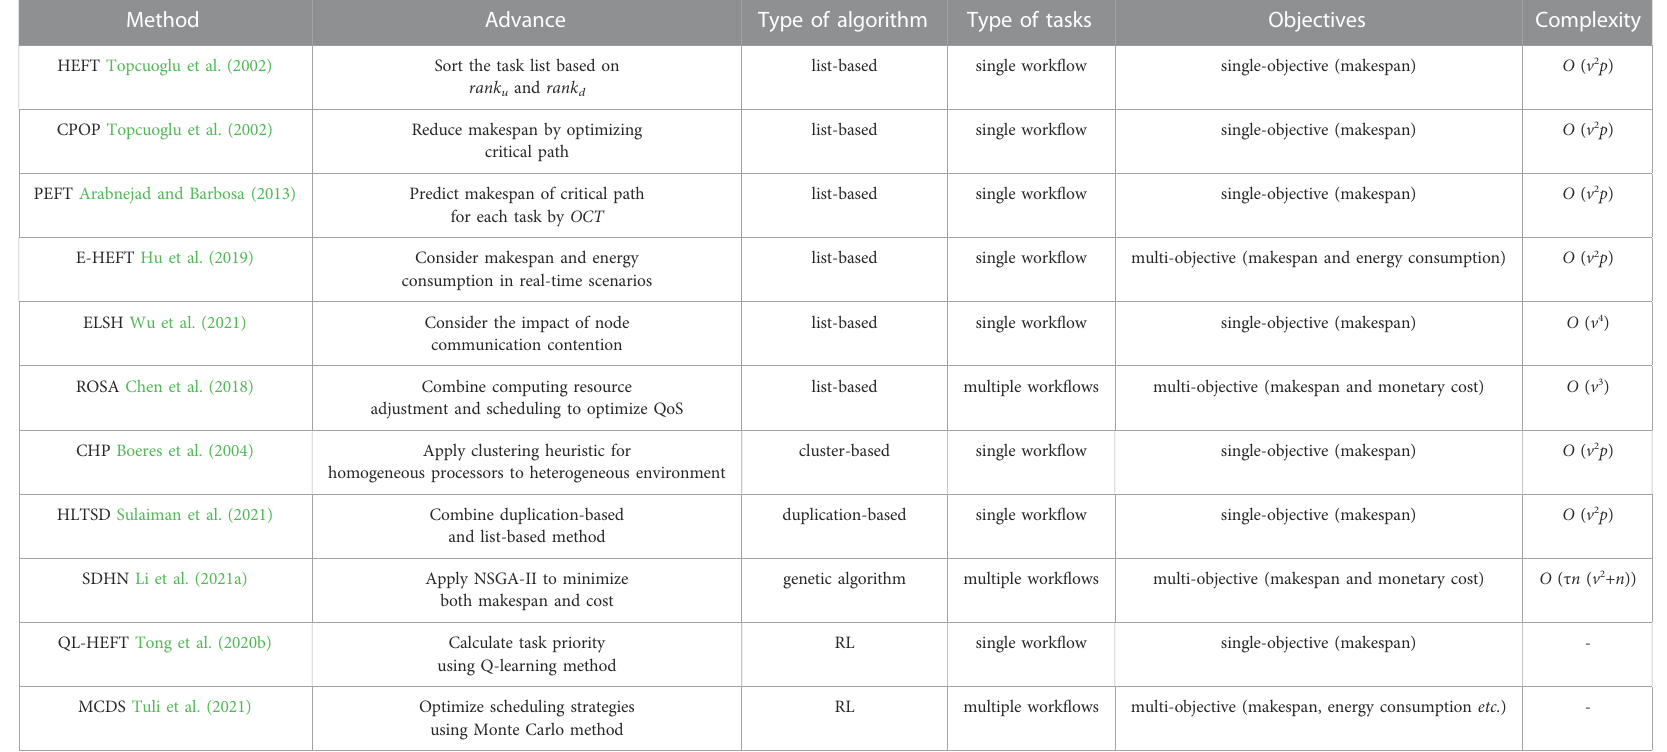
TABLE 2 Some promising methods for work fl ow